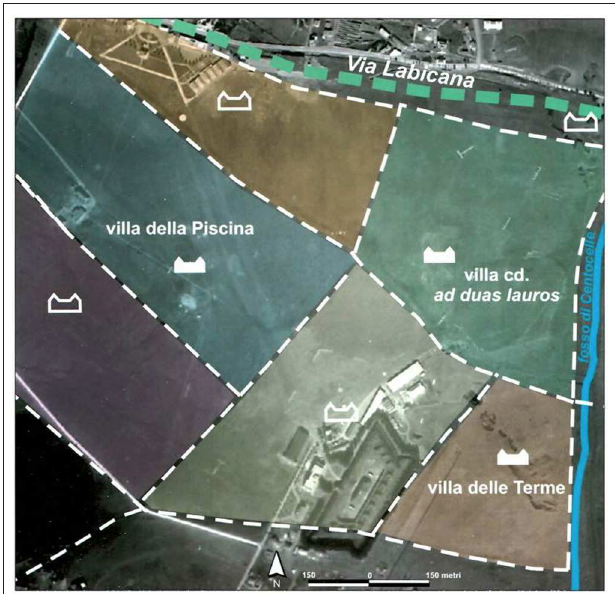
FIGURE 11 | Centocelle plain: hypothetical size of villa plots in the Imperial period (Volpe, 2007 (ed): 397, Figure 3 in Volpe (2007) (ed) Centocelle II. Roma SDO. Le indagini archeologiche. Soveria Mannelli: Rubbettino. Used with